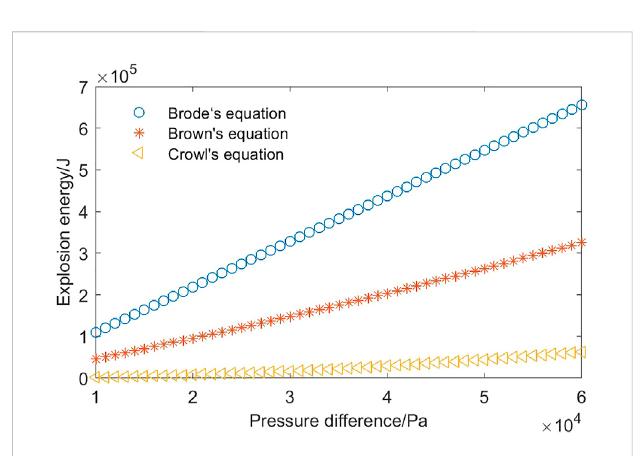
FIGURE 7 Explosion energy for envelopes at different pressure differences.